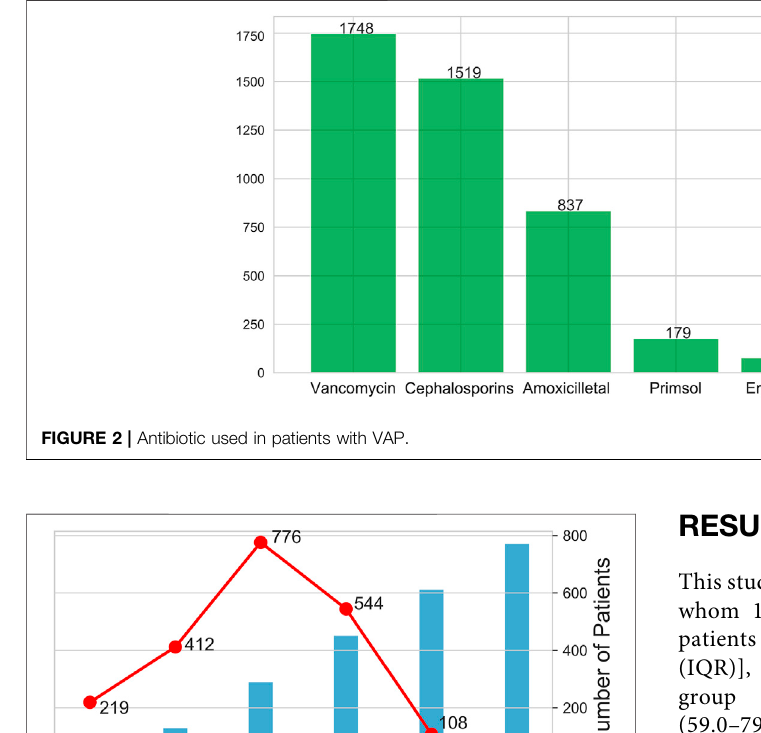
Frontiers in Pharmacology |